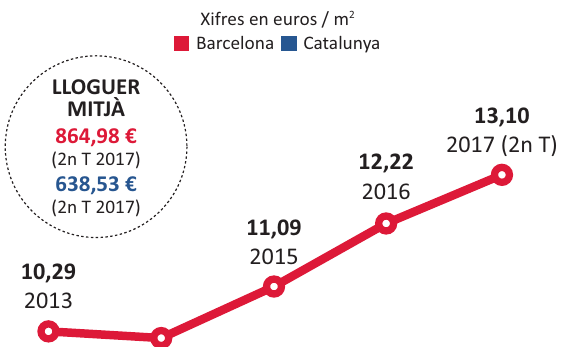
Figure 6. Barcelona rental price progress 2013–2017. Source: Institut Català del Sòl, in Ortega (2017).